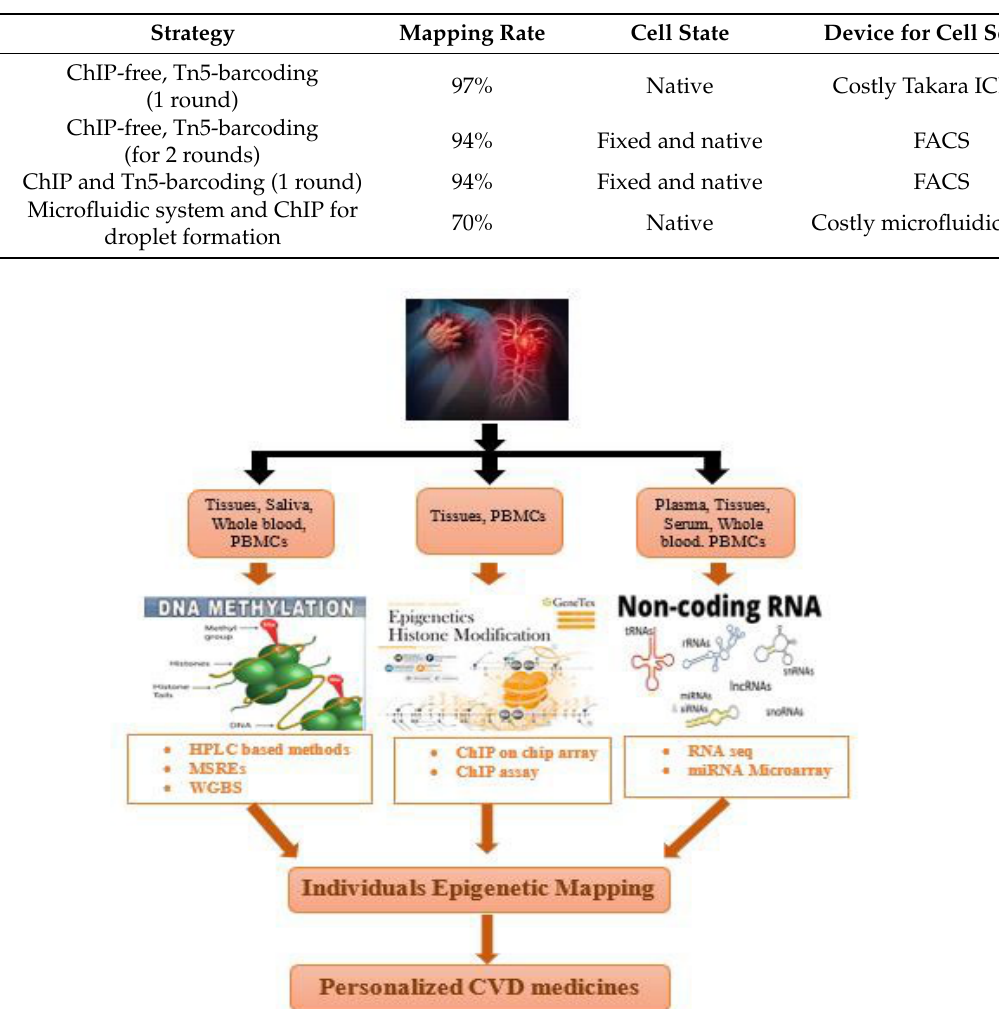
Table 4. Comparison of different scChIP seq methods [100].